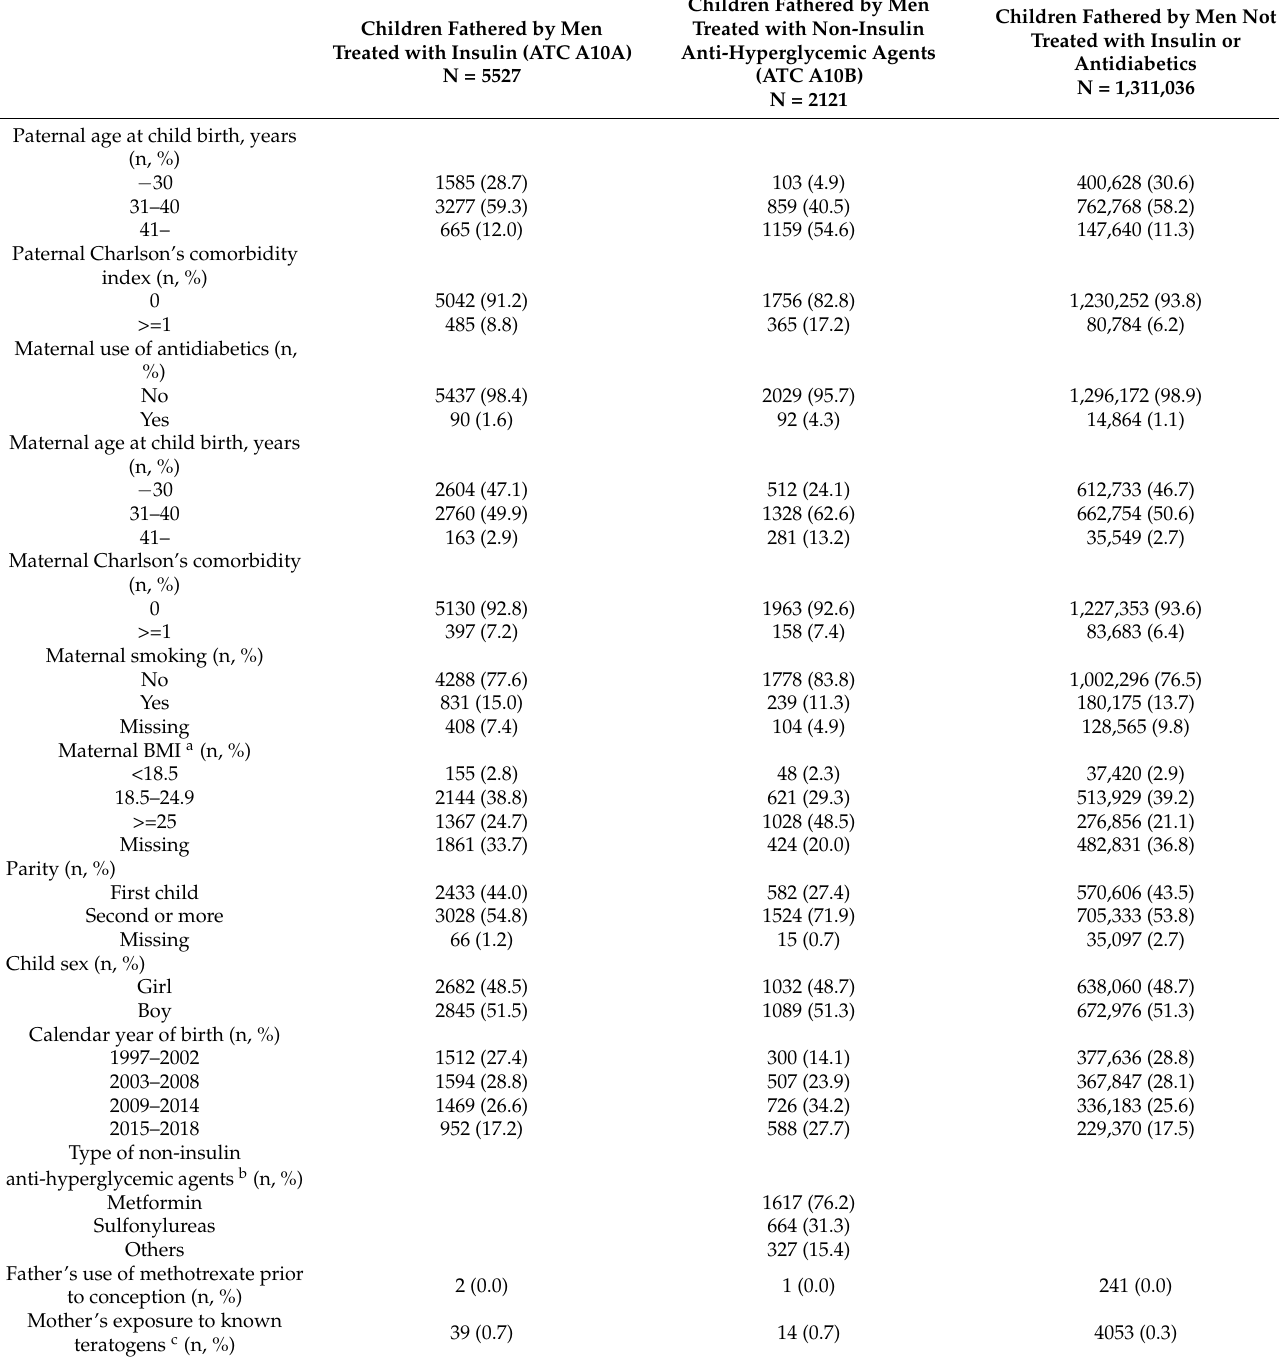
Table 1. Descriptive characteristics of the study population according to exposure status. Fathers exposed to insulin (ATC: A10A), fathers exposed to non-insulin anti-hyperglycemic agents (ATC: A10B), and non-exposed fathers (study period from 1997 to 31 December